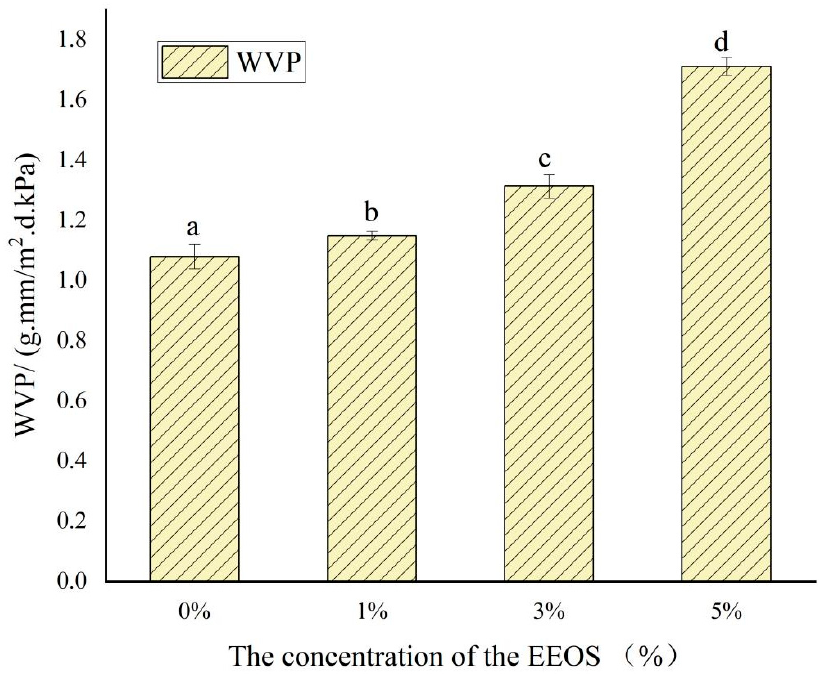
Figure 5. WVP of CS/ κ C, CS/ к C/EEOS I, CS/ к C/EEOS II, and CS/ к C/EEOS III composite films. a–d Values are given as means ± standard deviation. Different letters in the same line indicate significant difference ( p < 0.05).